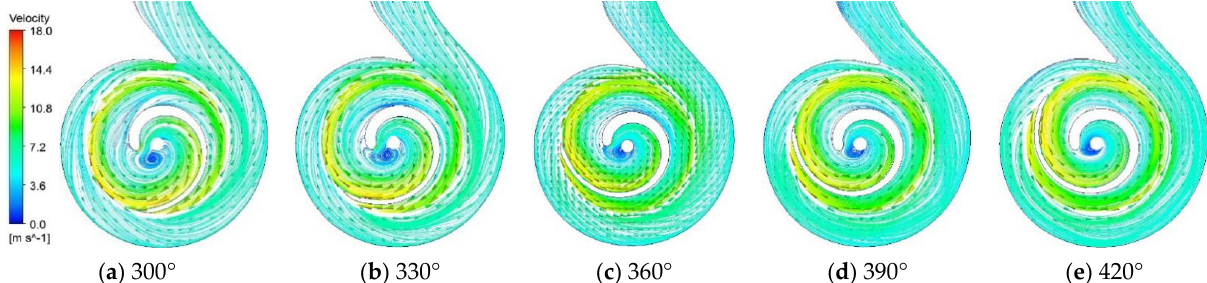
Figure 16. Velocity vector of the pump large flow rate condition (1.4 Q d ).